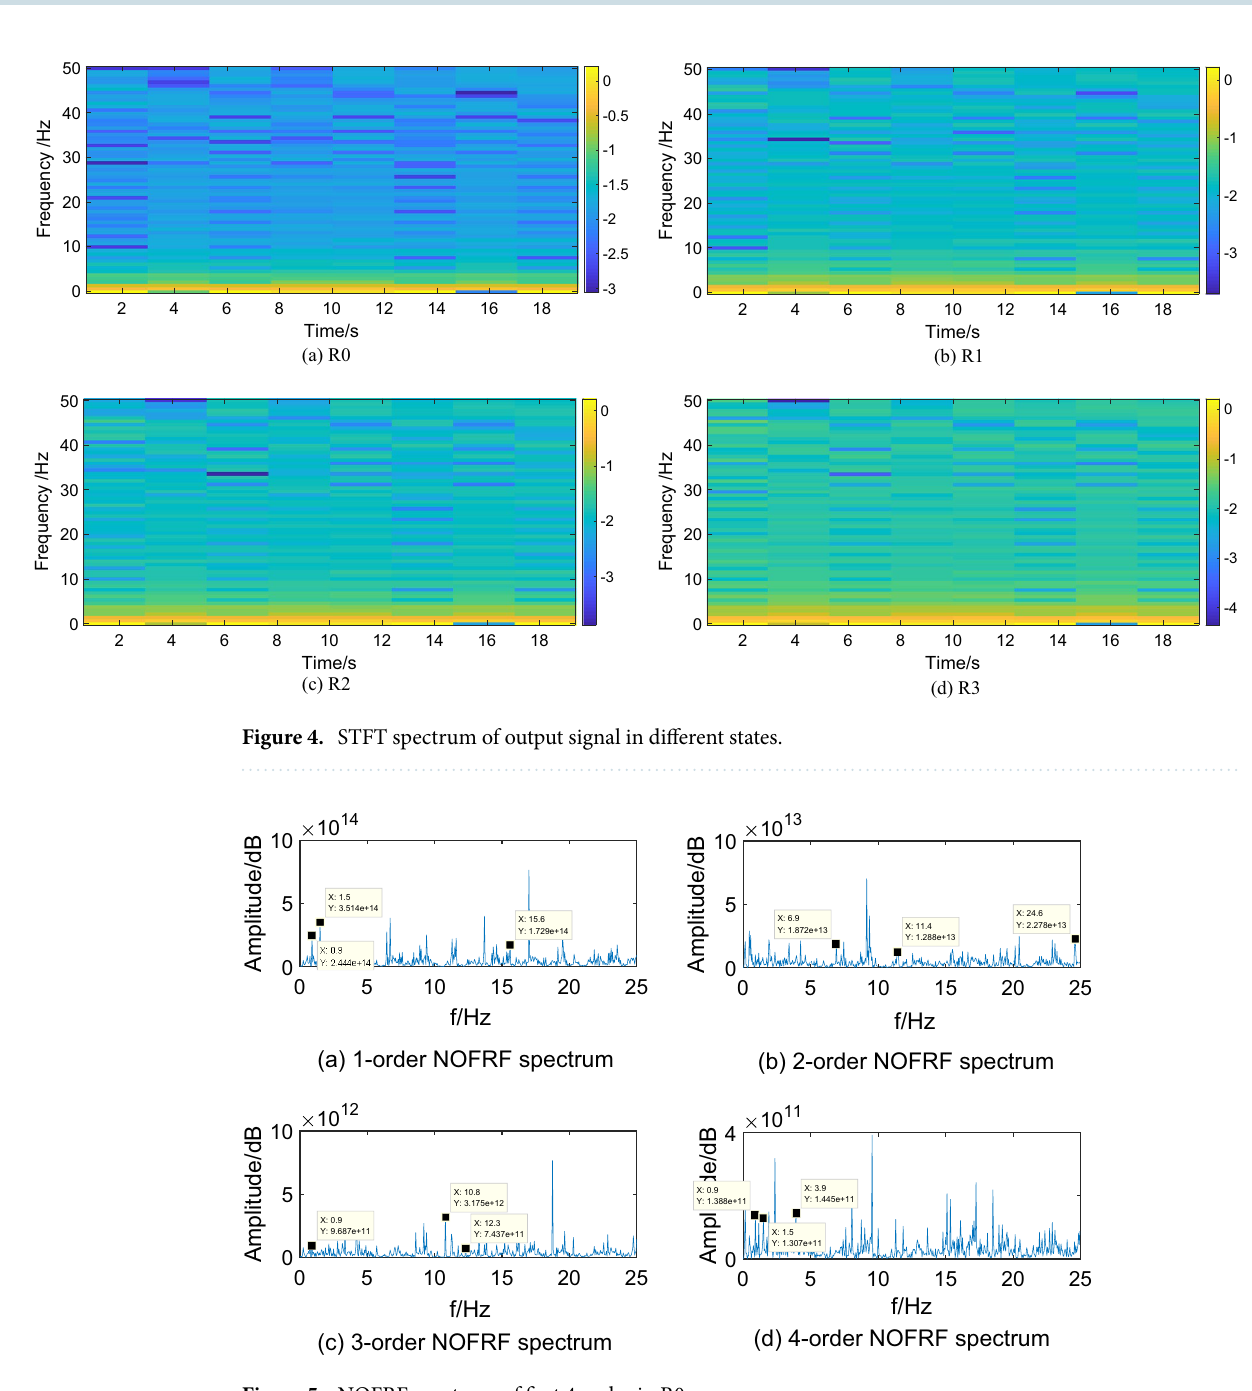
Figure 5. NOFRF spectrum of first 4-order in